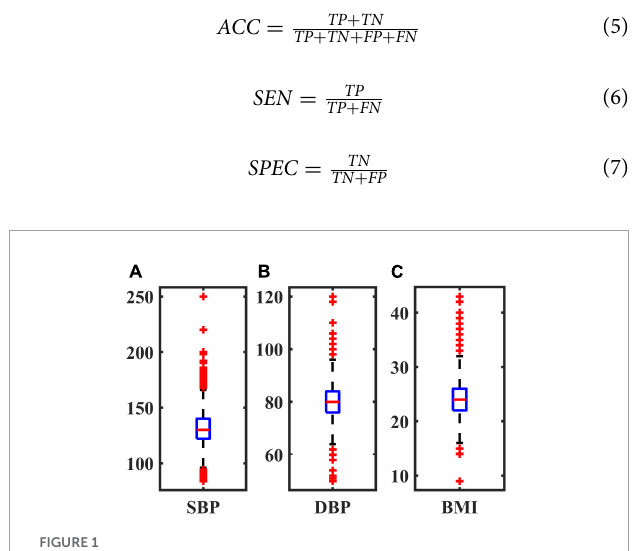
FIGURE1 Boxplot of three factors. (A) SBP; (B) DBP; (C)